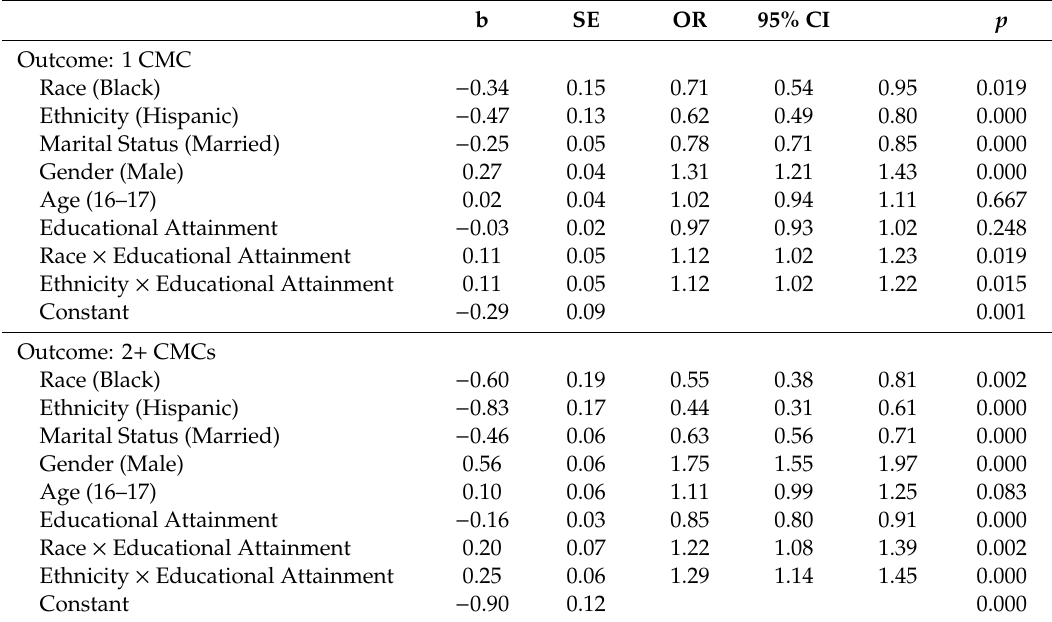
Table 5. Summary of multinomial regression (Model 4) with interactions on the number of Chronic Medical Conditions (CMCs) in the pooled